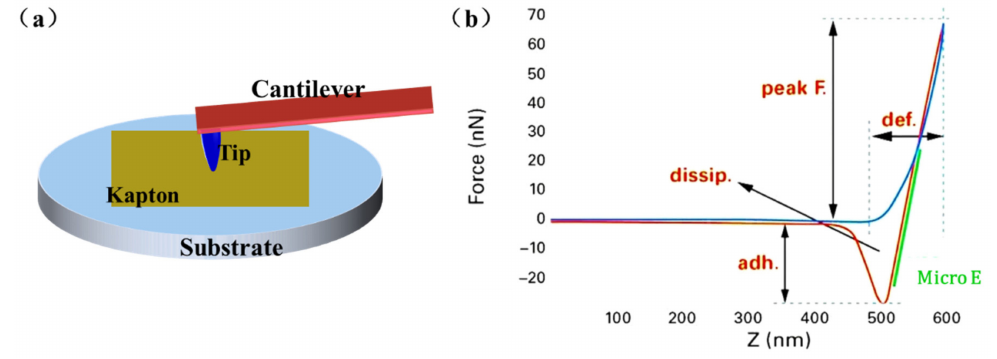
Figure 2. ( a ) Mechanical characterization of PI films by PFQNM technology; ( b ) typical force curve from